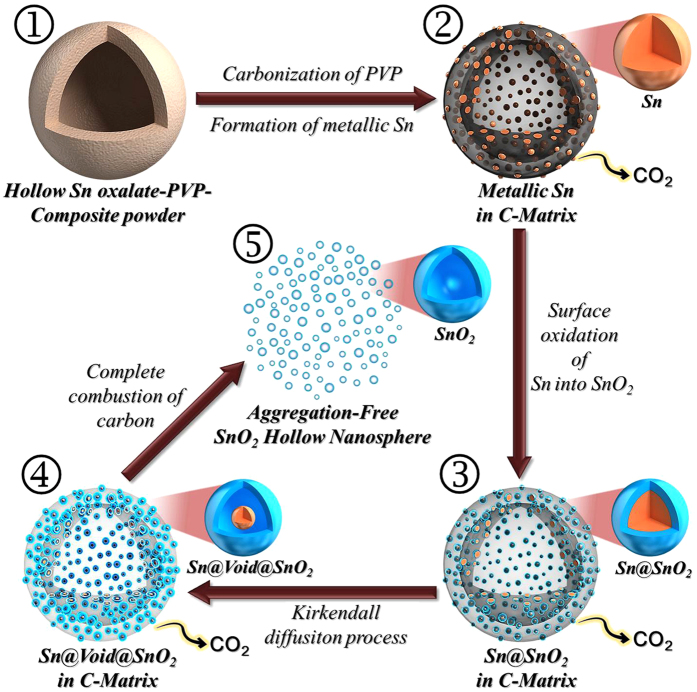
Schematic diagram for the formation mechanism of the aggregation-free SnO2 hollow nanospheres.